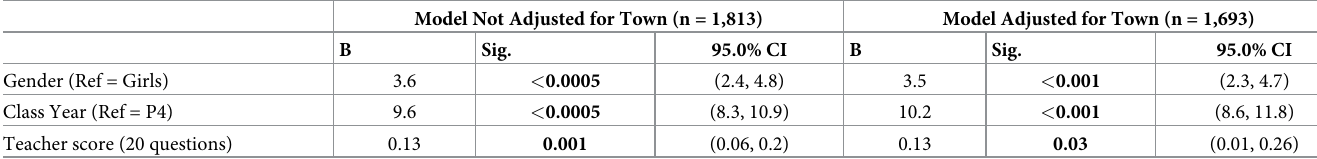
Table 3. Multivariate linear regression models with student scores on a 22-question UGS knowledge survey as the dependent variable and with gender, class year, and teacher score as independent variables, adjusted and unadjusted for